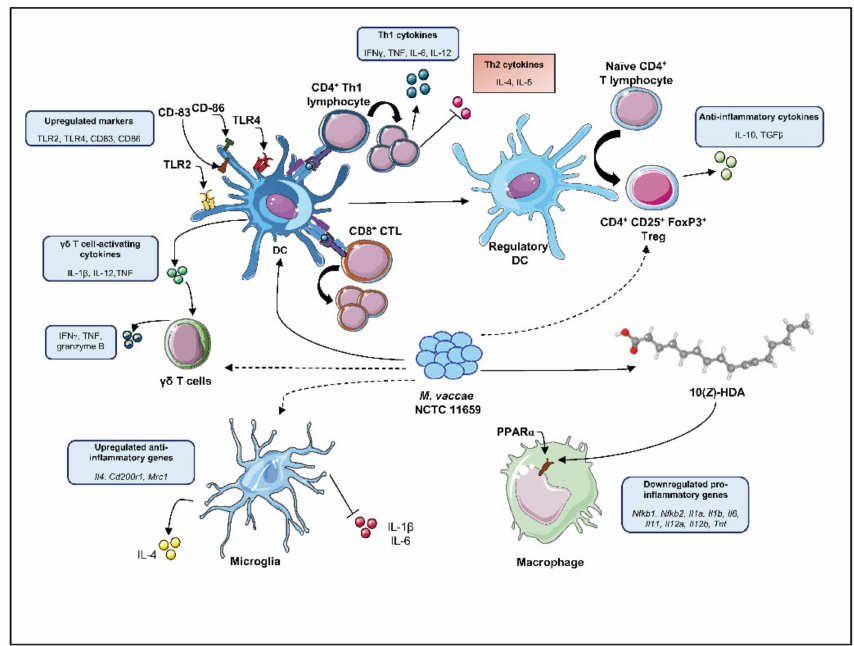
Figure 1. Pleiotropic effects of M. vaccae National Collection of Type Cultures (NCTC) 11659 on the immune system, promoting immunoregulation. Recognition of M. vaccae NCTC 11659 by dendritic cells (DCs) results in the upregulation of Toll-like receptor (TLR)2, TLR4, and of the maturation markers cluster of differentiation (CD)83 and CD86. It also results in the polarization and proliferation of CD4+ T lymphocytes toward a T helper (Th)1 phenotype with production of Th1 cytokines like interferon gamma (IFN γ ), tumor necrosis factor (TNF), interleukin (IL)6, and IL-12. M. vaccae NCTC 11659-stimulated DCs also promote the differentiation of CD8+ cytotoxic T lymphocytes (CTL) and gammadelta ( γδ ) T cells with antitumor activity as well as of CD4+CD25+ forkhead box P3 (FoxP3) + regulatory T cells (Treg). M. vaccae NCTC 11659 upregulates anti-inflammatory genes (i.e., Il4 , Cd220r1 , mannose receptor C-type 1 ( Mrc1 )) in hippocampal microglia, indicated by increased secretion of IL-4, while in contrast reducing secretion of proinflammatory markers such as IL-1 β and IL-6. Finally, the M. vaccae NCTC 11659-produced lipid 10( Z )-hexadecenoic acid (10( Z )-HDA) induces anti-inflammatory responses in isolated peritoneal macrophages via activation of peroxisome proliferator-activated receptor alpha (PPAR α ) and downregulation of proinflammatory genes (i.e., transcription factor nuclear factor-kappa B ( Nfkb1, Nfkb2 ), Il1a , Il1b , Il6 , Il11 , Il12a , Il12b , Tnf ). Solid-line arrows represent direct effects of M. vaccae NCTC 11659 while dashed-line arrows represent indirect effects. 3D image of 10( Z )-HDA retrieved from